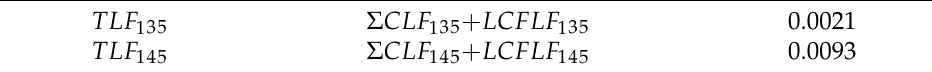
Table 8. EMB-135/145 total life fractions for missions.